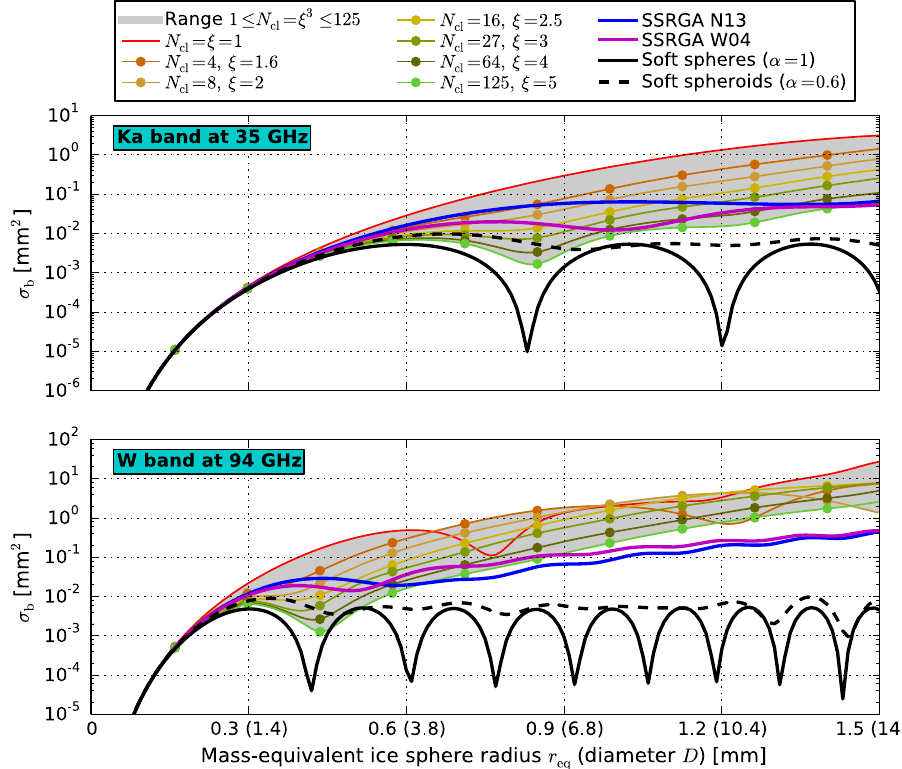
Figure 6. Modeled snowflake backscatter cross sections σ b at 35 and 94GHz for (i) collections of 1 ≤ N cl ≤ 125 randomly distributed ice spheres inside a spherical bounding volume of diameter D , corresponding to normalized surface-area-to-volume ratios of 1 ≤ ξ ≤ 5, for (ii) the self-similar Rayleigh–Gans approximation (SSRGA) applied to N13 and to W04 snowflake 3-D shape models, and for (iii) soft spheres and oblate spheroids with aspect ratios of α = 1 and α = 0 . 6, respectively. Results for (single) mass-equivalent ice spheres given by N cl = 1, for snowflakes modeled according to the SSRGA, and for soft spheres and spheroids were calculated at a resolution of (cid:49)r eq = 0 . 01mm. For collections of N cl = 4, 8, 16, 27, 64, and 125 ice spheres, dots mark values of σ b (D ; ξ) that were calculated at a resolution of (cid:49)r eq ≈ 0 . 14mm following Sect. 3.3, and lines indicate spline interpolations of the calculated σ b (D ; ξ) . Modeled σ b for the full range of considered snowflake diameters of D ≤ 23 . 6mm, for soft spheroids characterized by extreme aspect ratios of α = 0 . 2, and for microwave frequencies of 10 and 14GHz are shown in Fig. S3 in the